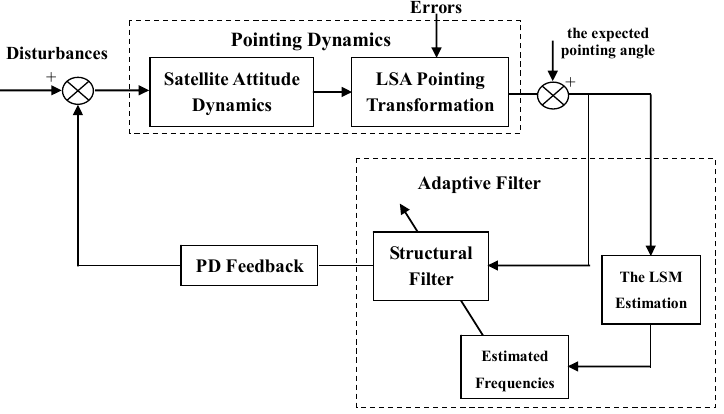
Figure 4. Adaptive filter control system. PD: proportional–derivative; LSM: least squares method; LSA: large satellite